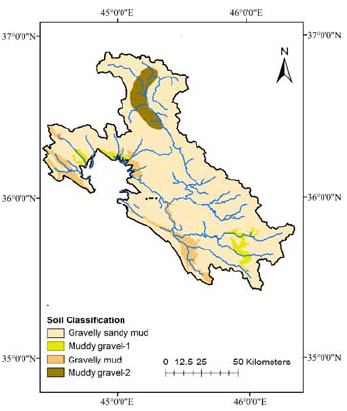
Figure 2. Soil type classification of the Dokan Reservoir watershed. Table 2. Percentages of different land use types for two years of the studied period.